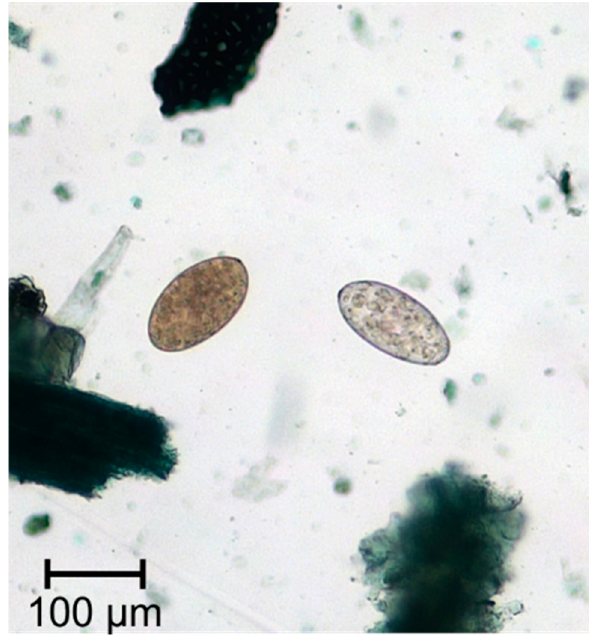
Figure 2. Eggs of Fasciola spp. and Paramphistomum spp.